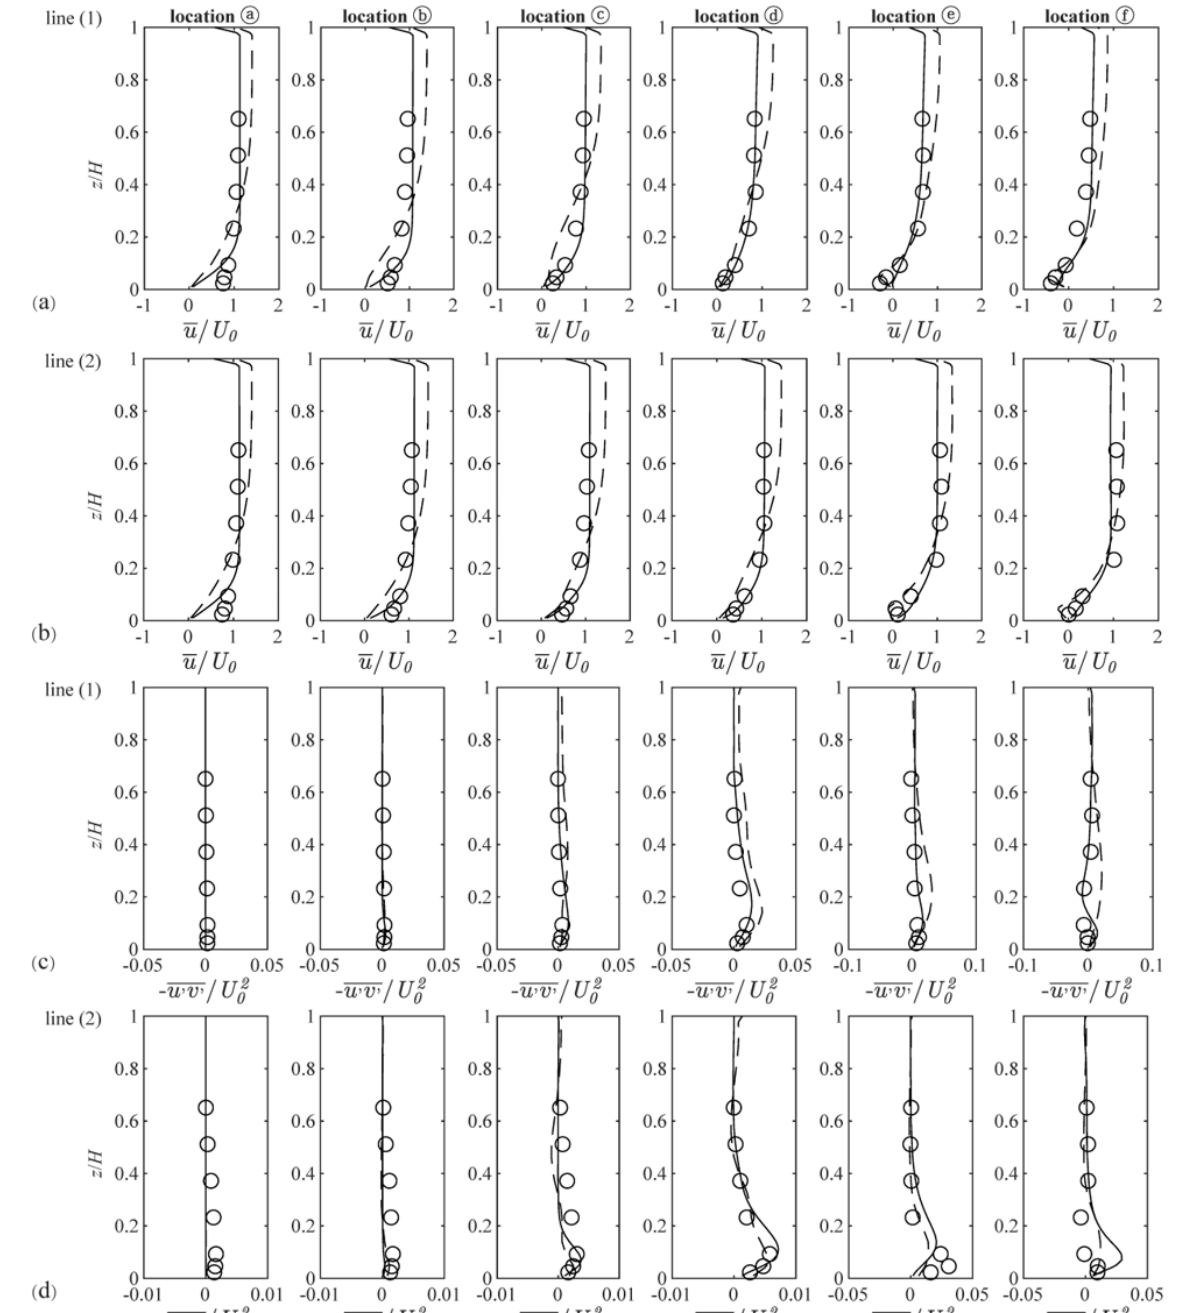
Figure 4. Validation results of vertical profiles of the dimensionless ( a , b ) time − averaged streamwise velocity and ( c , d ) primary shear stress at the locations of sampling lines (1) and (2) in Case 2. Circles represent the experimental values, solid lines represent the fine − mesh simulations, and dashed lines represent the coarse − mesh simulations.